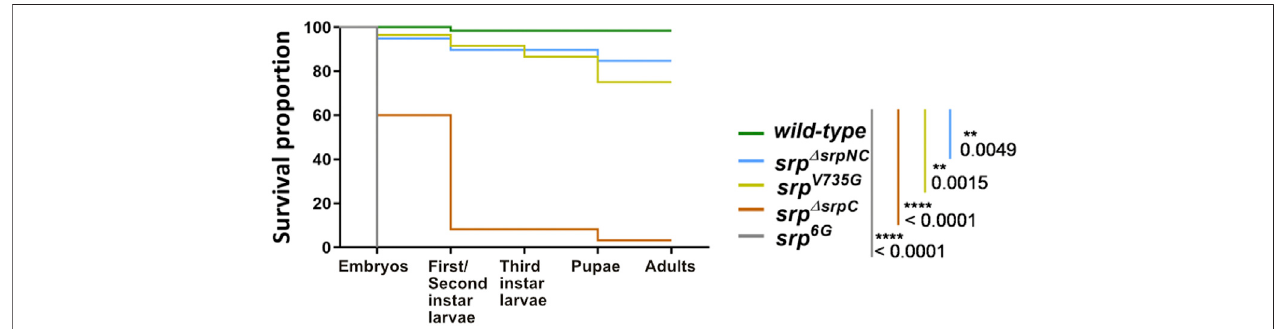
FIGURE 3 | SrpC, but not SrpNC, is required for Drosophila development. Kaplan-Meier survival curves of wild-type (green), srp Δ srpNC (blue, srpNC depletion), srp V735G (yellow, amino-acid substitution in the N-ZnF domain of srp protein), srp Δ srpC (brown, srpC transcript depletion) and srp 6G (grey, loss-of-function of